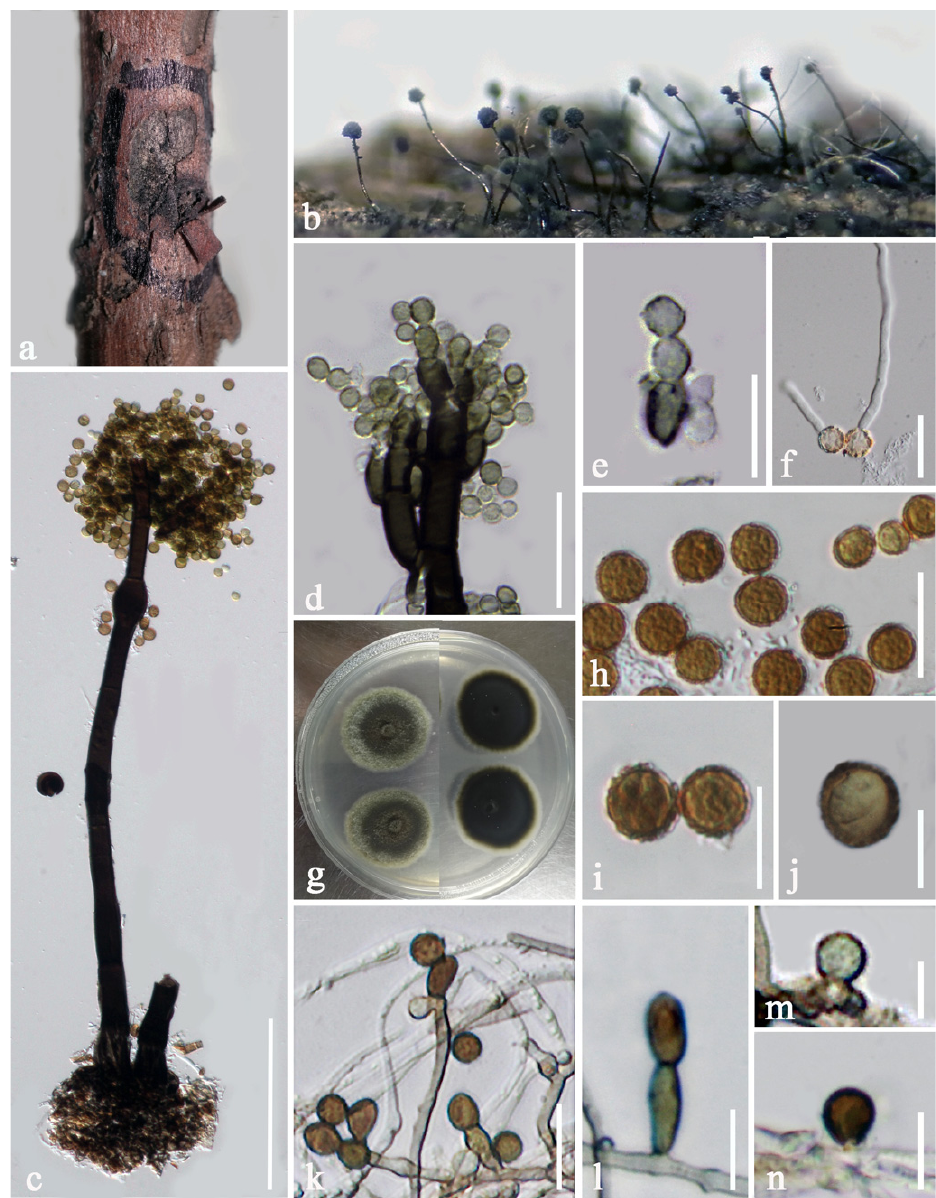
Figure 5. Periconia chimonanthi (KUN-HKAS 107380, holotype). ( a ) Located fungal colonies on host substrate; ( b ) closed up of conidiophores on host surface; ( c ) conidiophore with spherical conidial head; ( d , e ) conidiogenous cells bearing conidia in short chains; ( f ) germinated conidium; ( g ) colony from above and below; ( h – j ) conidia; ( k – n ) conidiogenous cells bearing conidia sporulated in vitro. Scale bars: ( c ) = 100 µm, ( d ) = 30 µm, ( f ) = 20 µm, ( e , h , k ) =15 µm, ( i , j , l , n ) = 10 µm, ( m ) = 5 µm. Saprobic on dead stems of Chimonanthi praecox (L.) Link. Sexual morph: Undeter- mined. Asexual morph: Colonies on the substrate superficial, numerous, effuse, dark brown to black, hairy. Conidiophores 410–635 µm long, 8.5–12 µm wide, broader at the